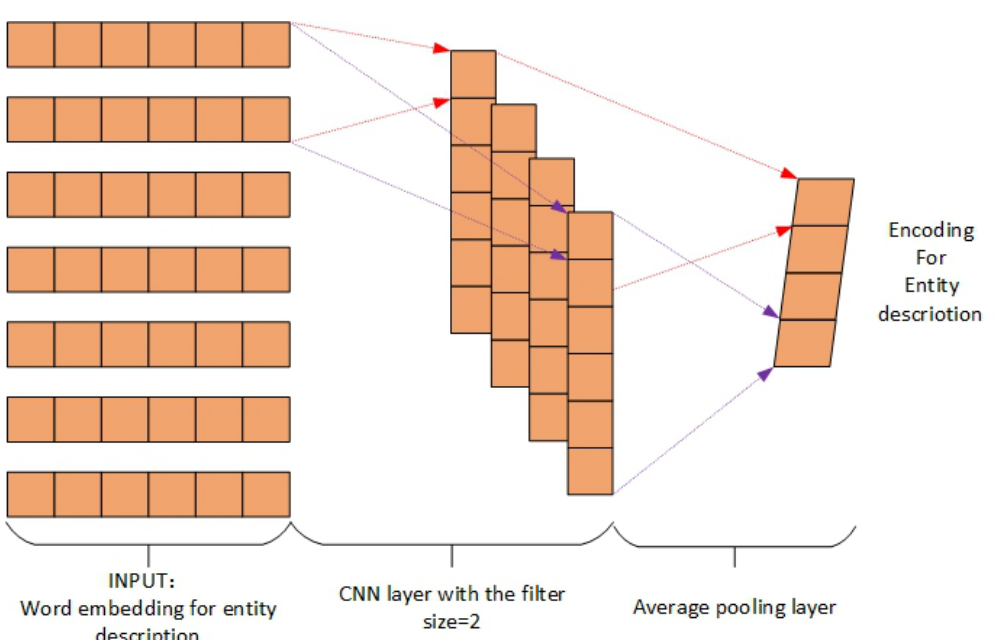
Figure 4. Encoding the description information with CNN. The input of this framework is the word embedding of the entity